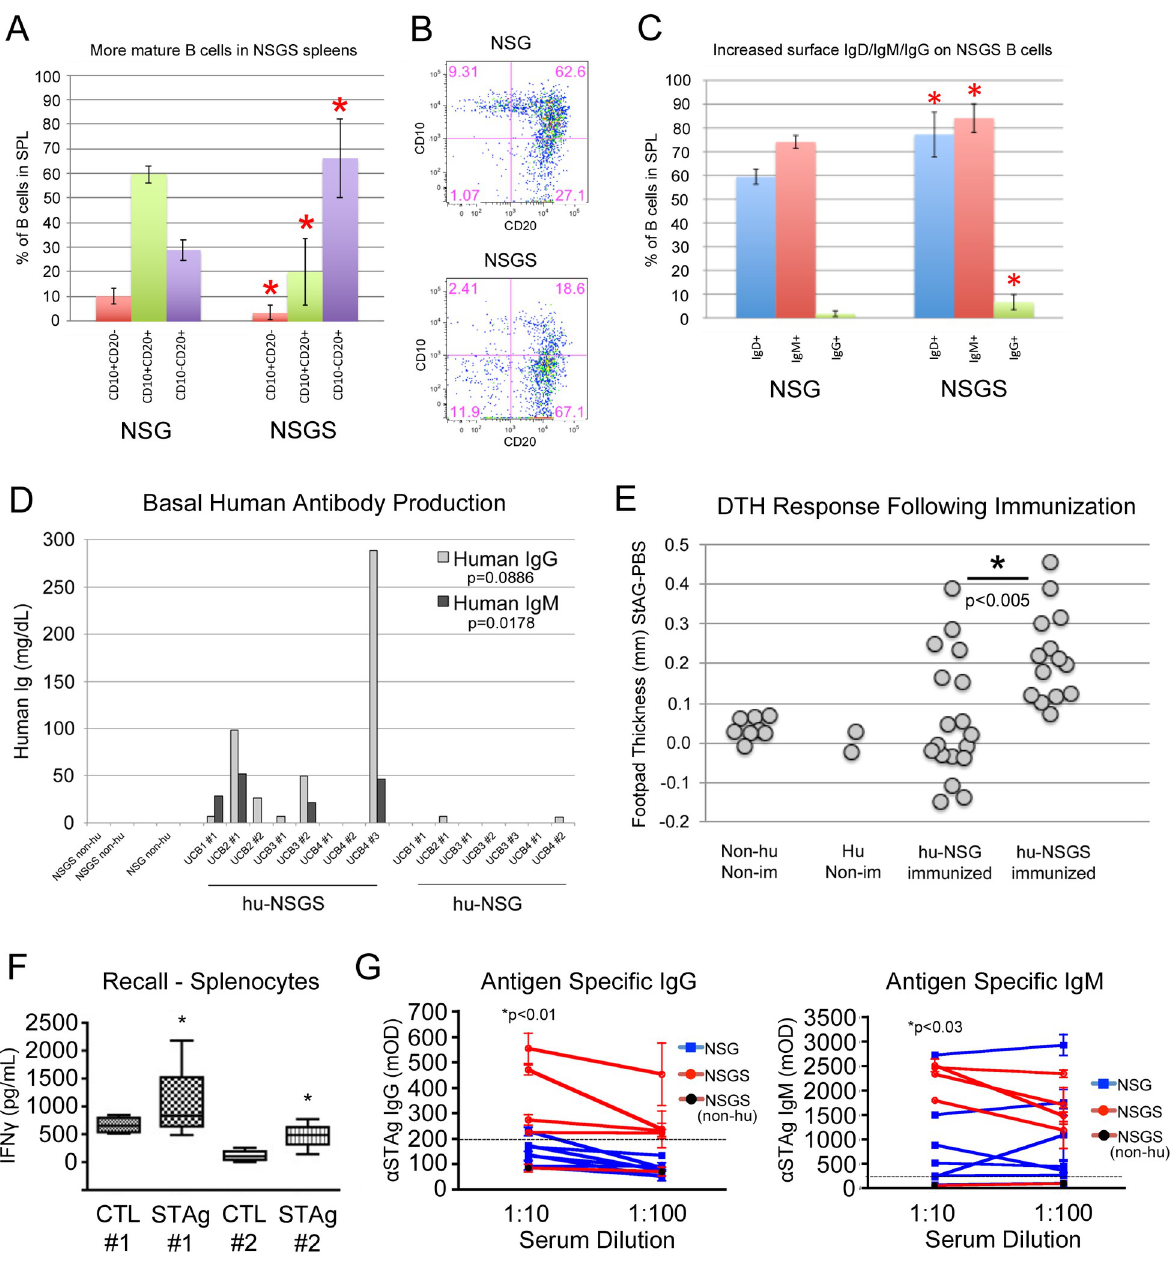
Fig 9. Humanized NSGS mice have more functional immune systems than humanized NSG mice. A) FACS analysis showing the average population distribution for the indicated marker combinations at 15 weeks of engraftment. B) Representative flow plots. C) IgD/IgM/IgG surface expression was measured on B cells from spleens at 15 weeks. D) Serum from long term engrafted mice (15–16 weeks) was tested for the presence of human IgG and IgM. E) Mice immunized three times with a toxoplasma extract were challenged with a final injection of extract or PBS into the footpads. Swelling was measured 24 hours later and thickness of the PBS-injected footpad was subtracted from the thickness of the extract-injected footpad. F) Splenic cell isolates from these mice were subjected to STAg extract or PBS in vitro and the media was tested for release of IFNy. G) Serum from the mice was tested for toxoplasma specific IgG and IgM antibodies by ELISA assays. Asterisks indicate p value less than 0.05 by Student’s T Test or paired T Test (panel D, F).